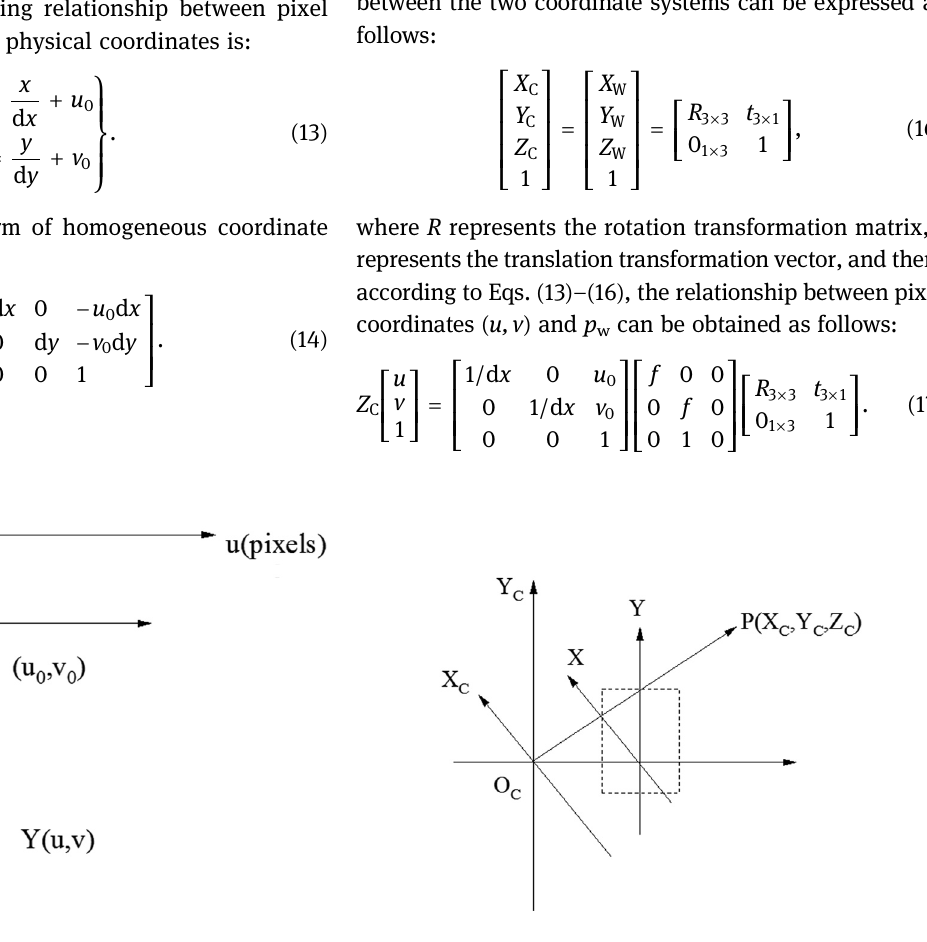
Figure 1: Pixel coordinate system and image coordinate system. Figure 2: Camera imaging